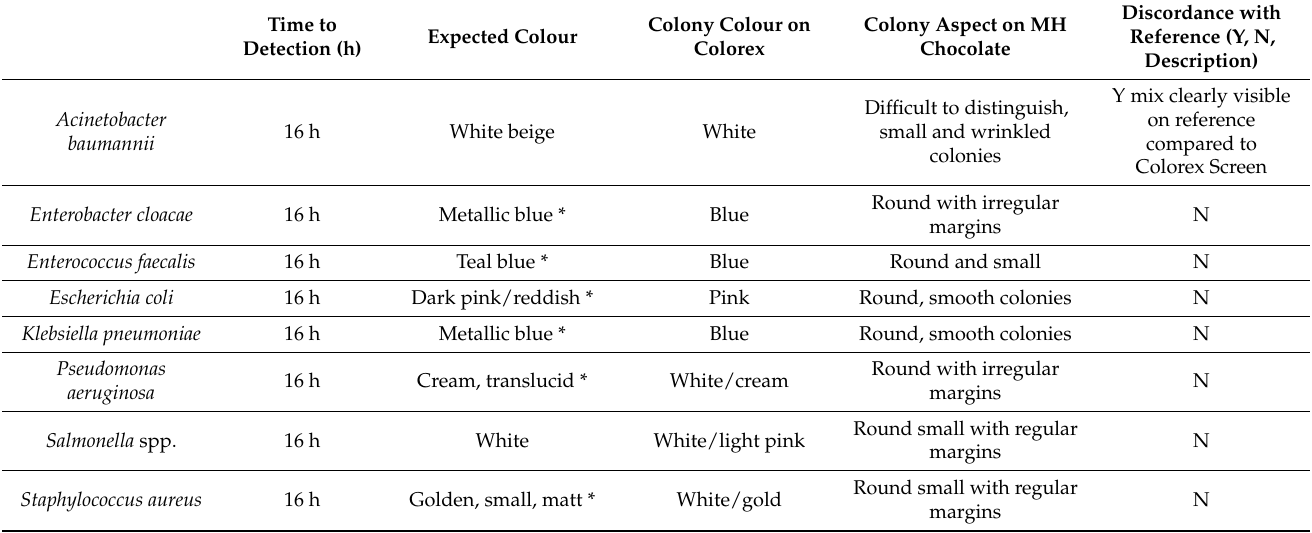
Table 7. Table of discrepancies between InTray Colorex Screen and reference media for polymicrobial cultures. Expected colours are either from the manufacturer IFU (* Biomed Diagnostics), or as shown on reference